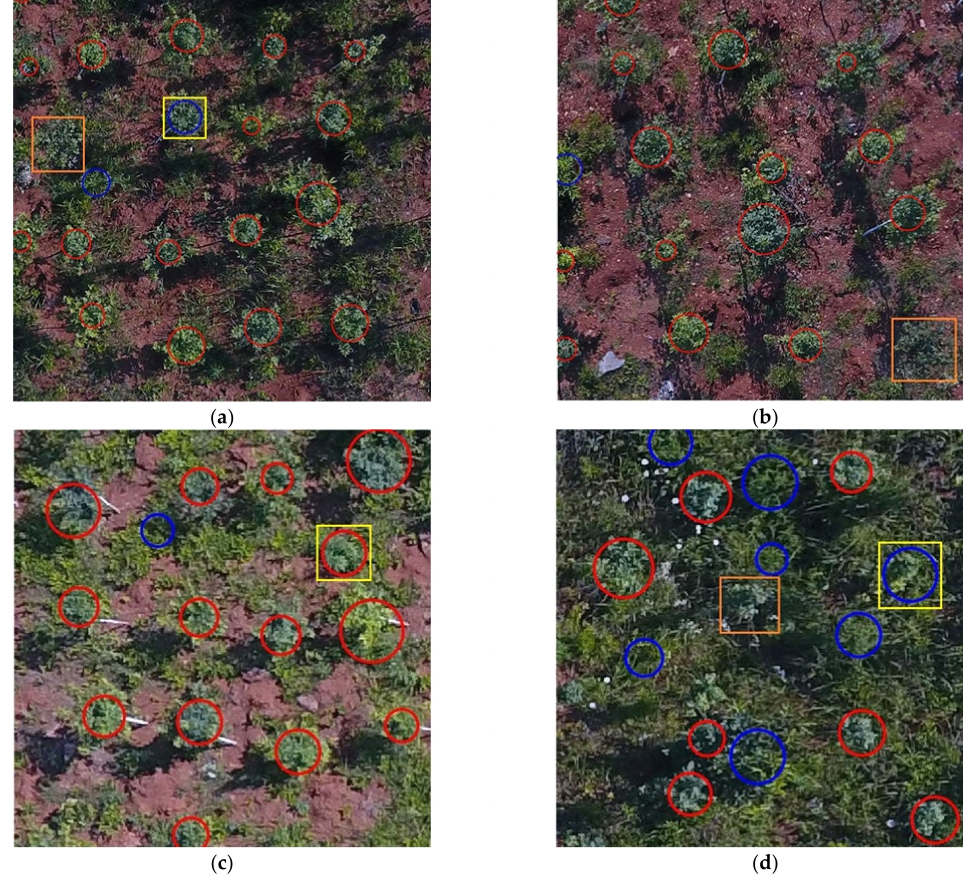
Figure 9. Recognition errors and omissions detected during performance evaluation. ( a ) The recognition results under 20 m, high FVC, and IB conditions. ( b ) The recognition results under 20 m, low FVC, and IB conditions. ( c ) The recognition results under 35 m, high FVC, and SB conditions. ( d ) The recognition results under 35 m, very high FVC, and IB conditions. The red circles mark the tree crown areas that were correctly identified, the blue circles mark the weed areas that were correctly identified, the orange rectangle marks the missing tree crown area, and the yellow rectangles mark the incorrectly identified